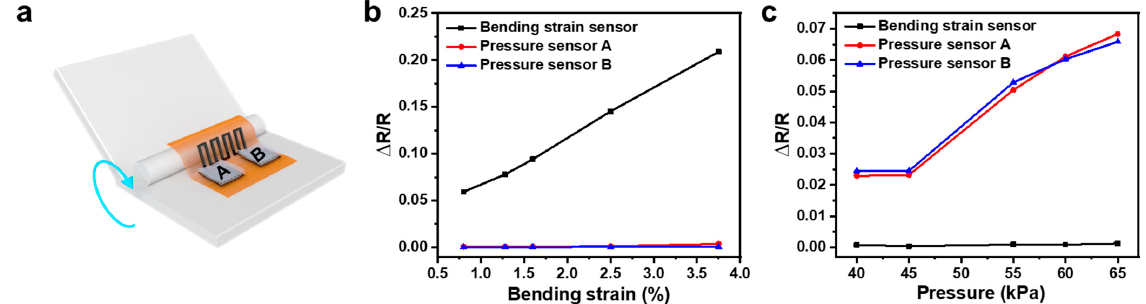
Figure 13. ( a ) Schematic diagram of the experimental setup for the system’s crosstalk characterization. Responses of dif ‐ ferent sensors in the integrated system under ( b ) a bending strain and ( c ) pressure.